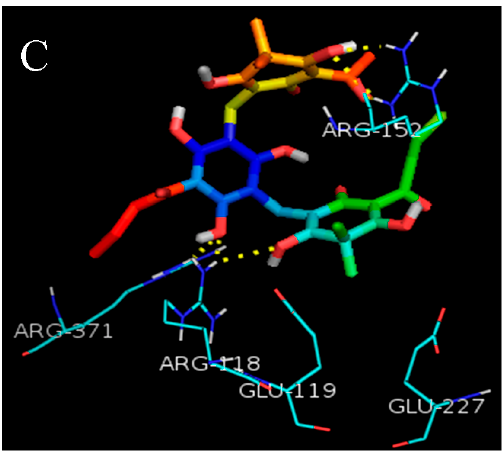
Figure 3. Binding modes of dryocrassin ABBA ( A ); filixic acid ABA ( B ) and filixic acid ABB ( C ) with key residues of NA. Table 1. Vina energy scores of the screened ten phloroglucinols bound to NA.